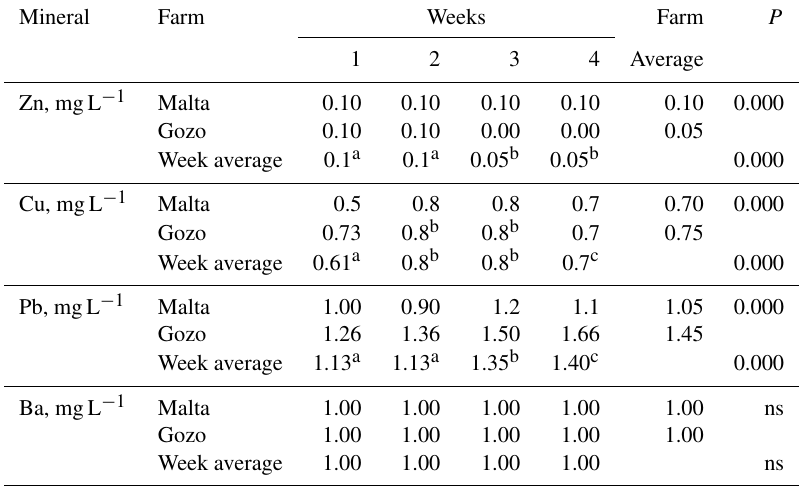
Table 6. Milk mineral content in two different farms during the observed period. Mineral Farm Weeks Farm P 1 2 3 4 Average Zn, mgL − 1 Malta 0.10 0.10 0.10 0.10 0.10 0.000 Gozo 0.10 0.10 0.00 0.00 Week average 0.1